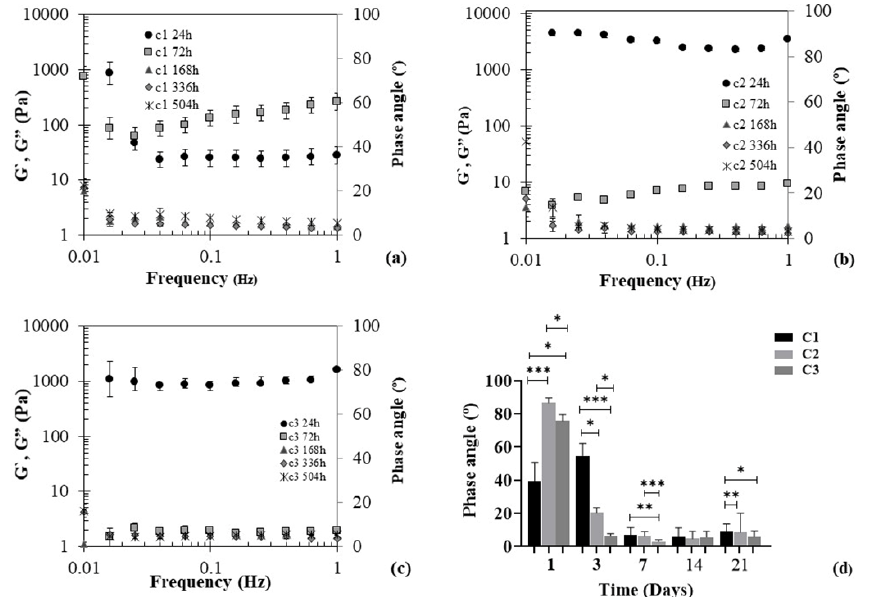
Figure 4. Mechanical spectra of Ty–GG / SF hydrogels C1 ( a ), C2 ( b ) and C3 ( c ) and phase angle values ( d ) at different timepoints (24, 72, 168, 336 and 504 h). G ′ (elastic moduli) and G ″ (viscous moduli). Significant differences *** p < 0.001, ** p < 0.01 and * p < 0.05, by nonparametric Kruskal–Wallis test. There are not significant differences.